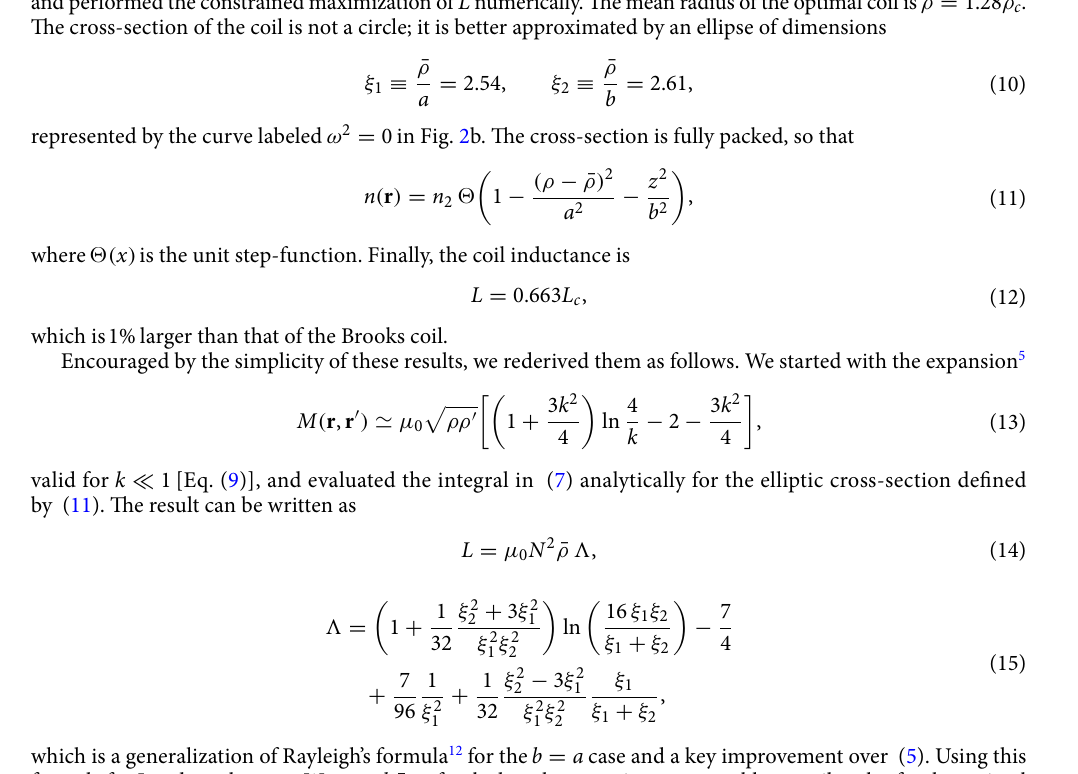
30 grid. The curves serve × 2